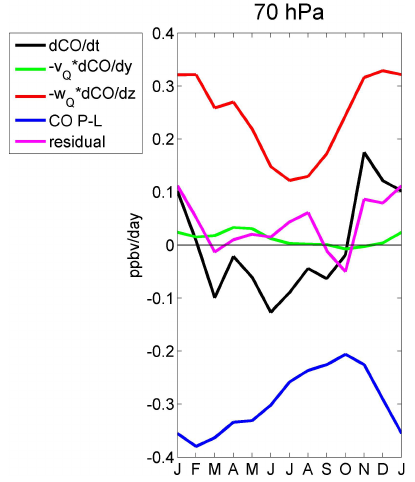
Fig. 7. Mean seasonal cycle (2005–2010) of the terms in the CO continuity equation at 70hPa averaged over 18 ◦ N–S (ppbvday − 1